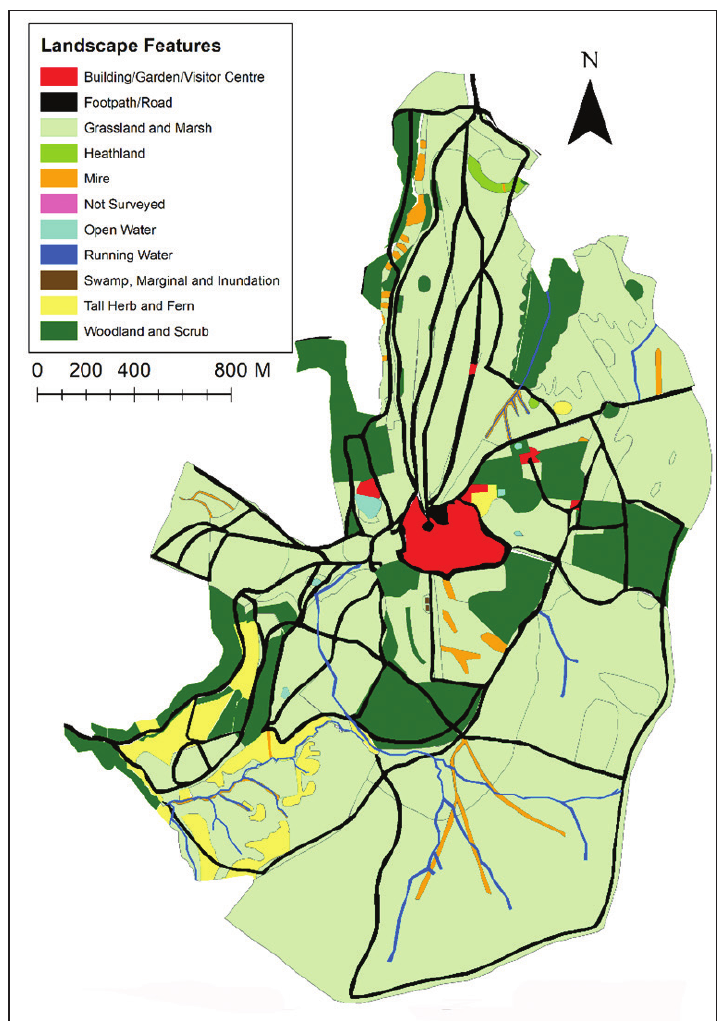
Figure 1. Map of landscape features. Each landscape feature is shown as a different colour. Data collected from Lyme Park, Disley, UK, in